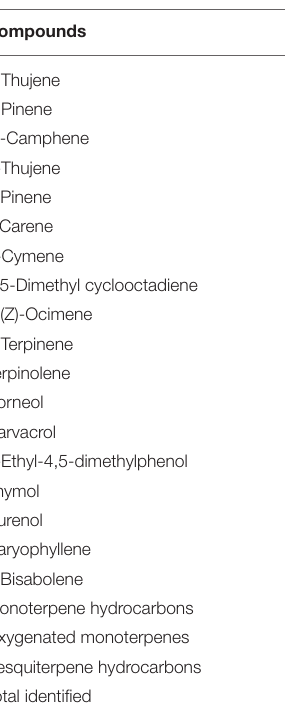
TABLE 1 | Chemical composition of Thymus proximus essential oil.